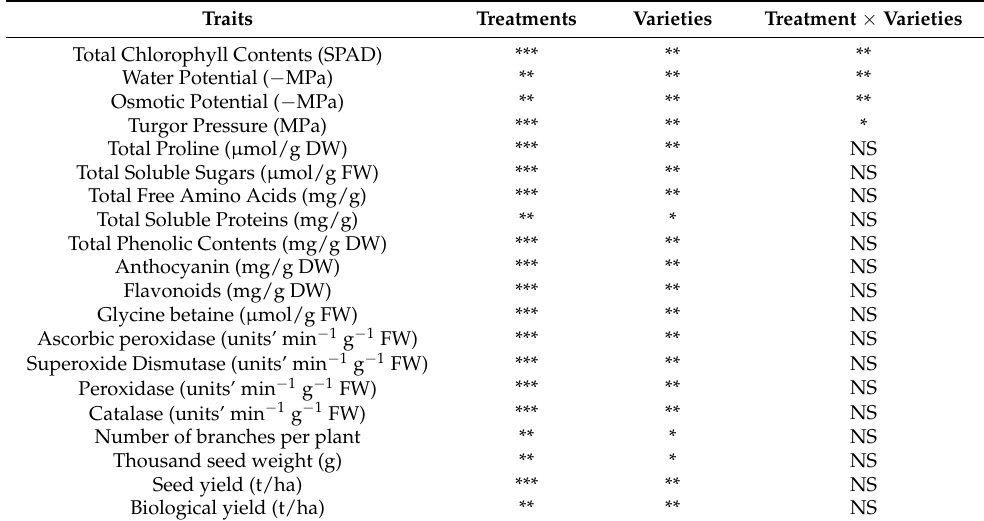
Table 1. Analysis of variance (ANOVA) of growth, water relations, biochemical, osmoprotectants, antioxidant, and yield parameters of camelina and canola under drought stress by foliar-applied Selenium. Traits Treatments Varieties Treatment × Varieties Total Chlorophyll Contents